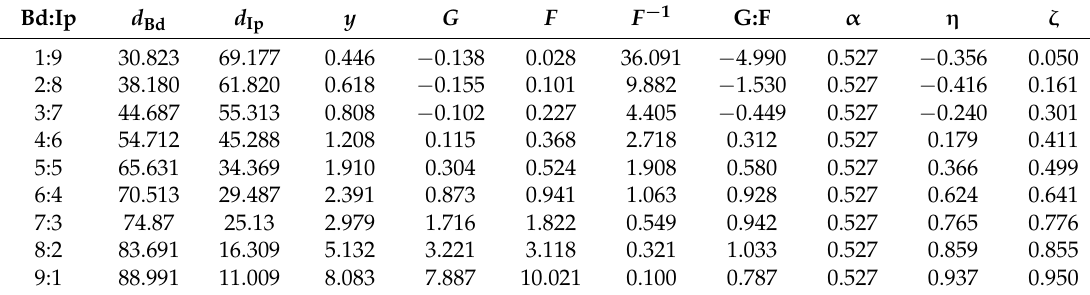
Table 6. Calculation data for reactivity ratio of Bd and Ip for the resulting copolymers obtained at different Bd:Ip mole ratios from 1:9 to